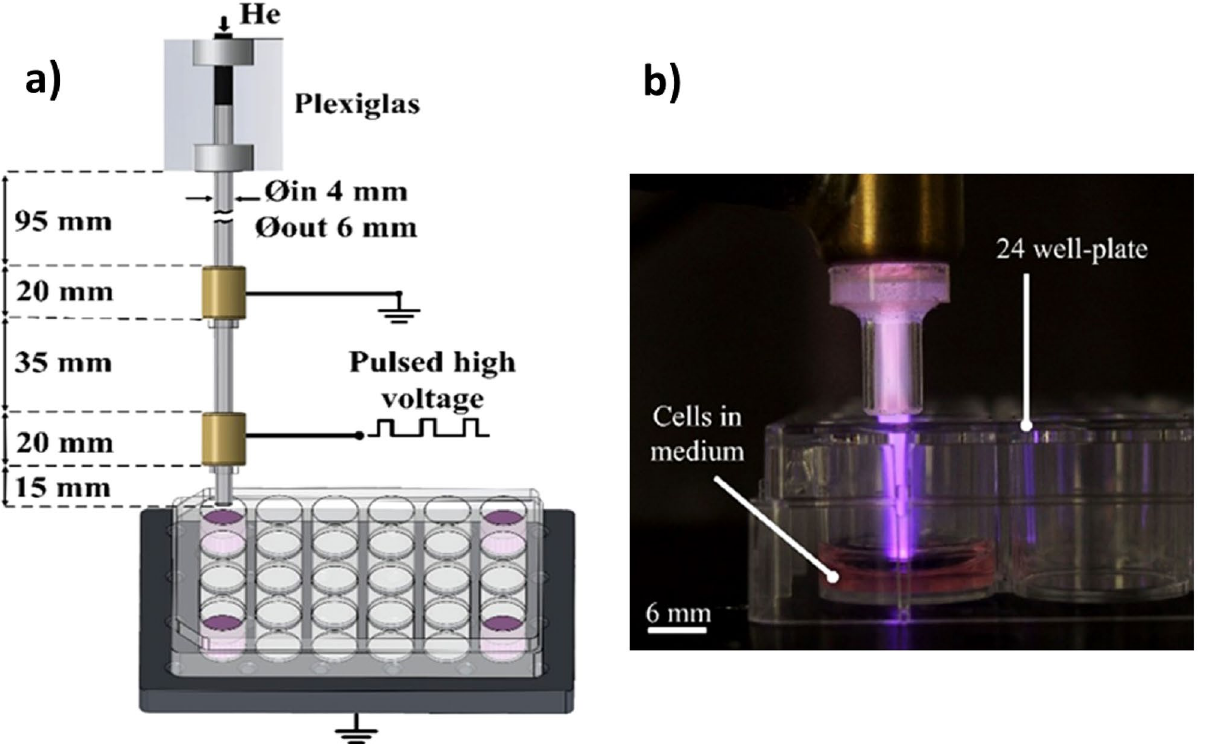
Figure 8. Design of the plasma jet reactor used for the present treatments. The electrode pair is driven by square high voltage pulses. ( a ) The specimens are placed in 24-well clear flat bottom plates hold on a grounded surface. ( b ) Typical image of the visible plasma plume in contact with the cell-medium specimen during the